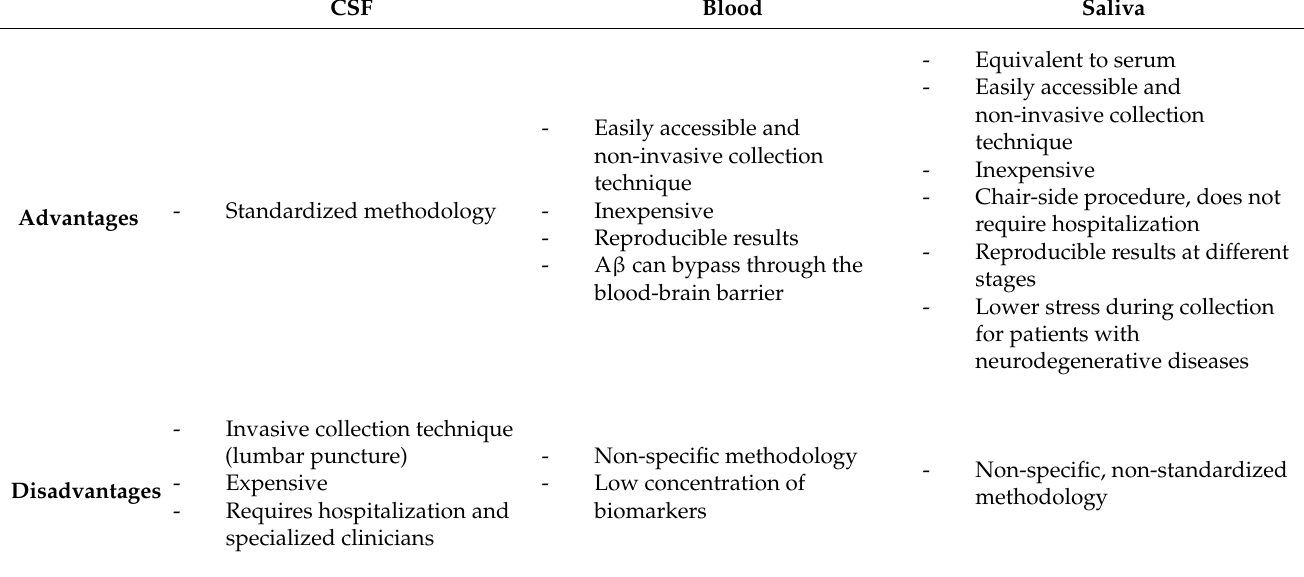
Table 1. Summary of advantages and disadvantages of saliva as a biological fluid in the determination of biomarkers compared to CSF and